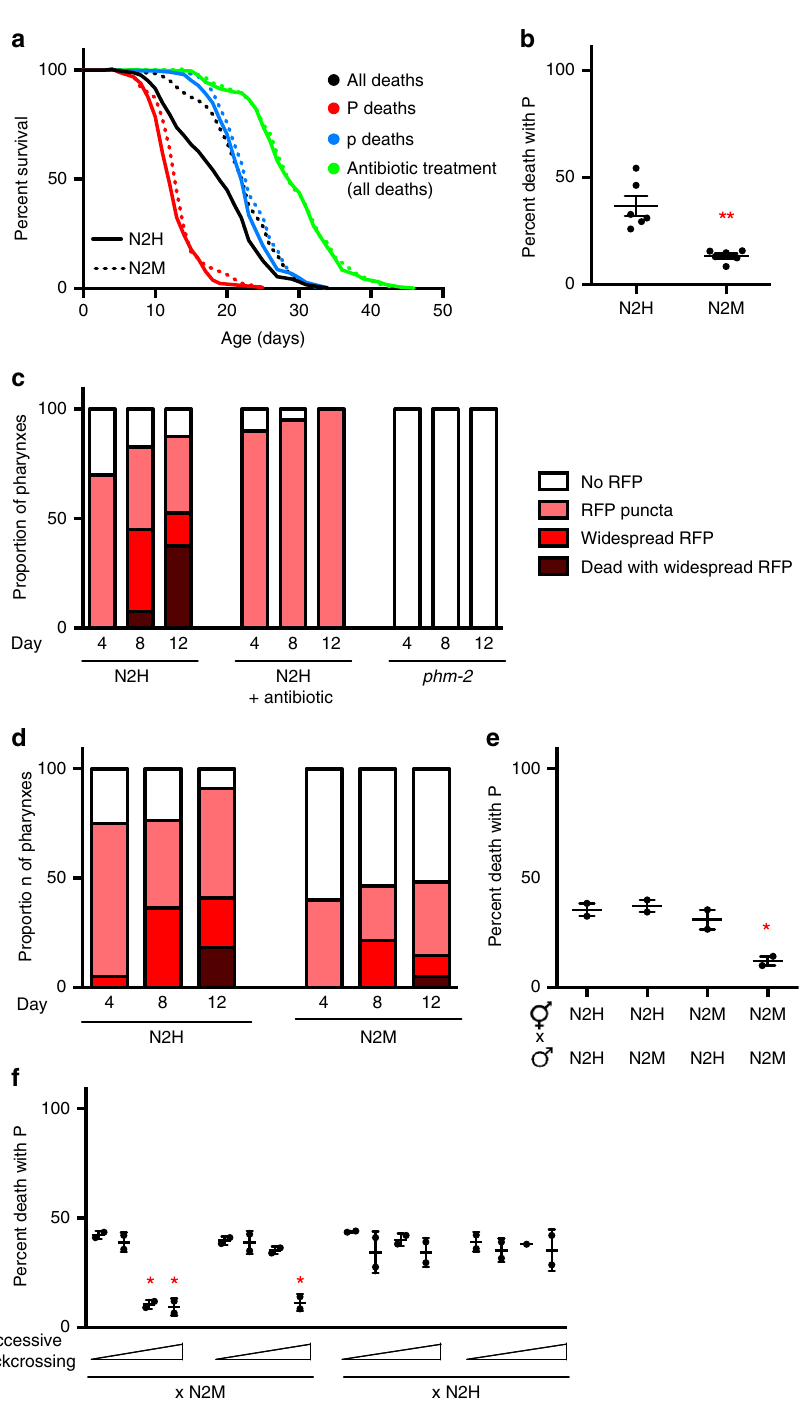
Fig. 1 N2M is resistant to pharyngeal infection. a N2M (dashed lines) is longer lived than N2H (solid lines) ( + 16.6%, p < 0.0001, log rank test), yet neither P or p N2M subpopulations are long lived. N2M longevity disappears after treatment with antibiotics. Whole population in black, P death sub-population in red, p death in blue, and antibiotic-treated in green. See Supplementary Table 1 for full statistics, and Supplementary data 1 for raw mortality data. b Necropsy analysis of the two N2 lines. N2M experience less P death than N2H. Error bars represent s.e.m. of six trials. p = 0.0031, Student ’ s t test. c Antibiotic and phm-2 mutants suppress P at different stages. Pharyngeal invasion and widespread infection were scored using high magni fi cation epi fl uorescence microscopy in worms fed RFP-expressing bacteria. No detectable RFP within pharyngeal tissue is shown in white, initial invasion with RFP puncta in pink, widespread RFP in red, and worms that have died with swollen pharynxes in maroon. Mean of two trials, n = 18 – 20 per time point in each trial. d N2M is more resistant to initial bacterial invasion. Colour coding as in ( c ). Mean of two trials, n = 20 – 25 animals per time point in each trial. e Reduced P frequency in N2M is not a consequence of parental mating. Error bars represent s.d. of two biological replicates. p = 0.0234 for N2M × N2M mating progeny, Student ’ s t test. f Resistance to P death following successive rounds of backcrossing is consistent with Mendelian segregation of a single mutant locus. Error bars represent s.d. of two biological replicates. Asterisk indicates p < 0.05, Student ’ s t test. See Material and Methods for detail. Source data for ( b – f ) are provided as a Source Data fi